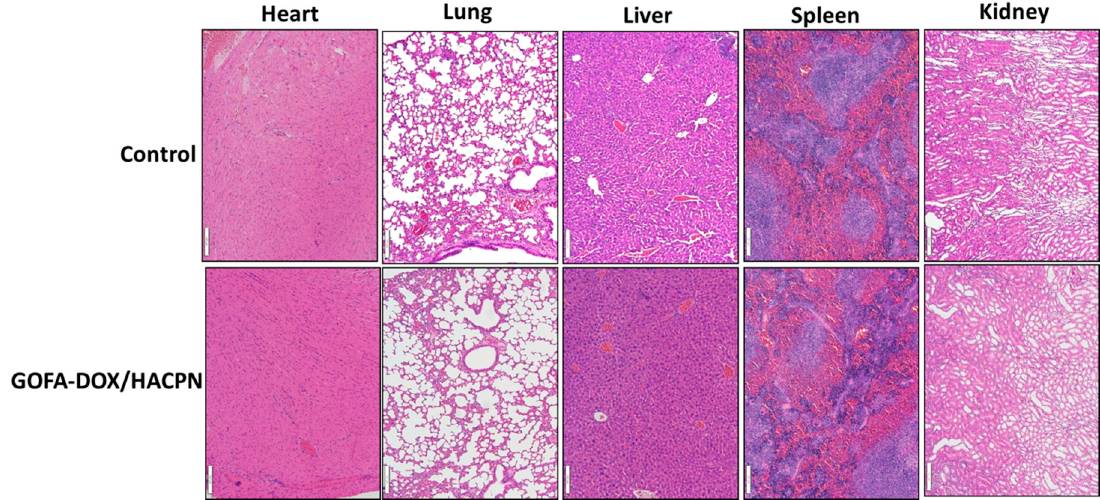
Figure 11. Histological examination of heart, lung, liver, spleen and kidney tissues by H&E stain after euthanization at day 21. Tissue biopsy did not reveal any observable differences between the control and the GOFA-DOX/HACPN group. Bar = 100 μ m.